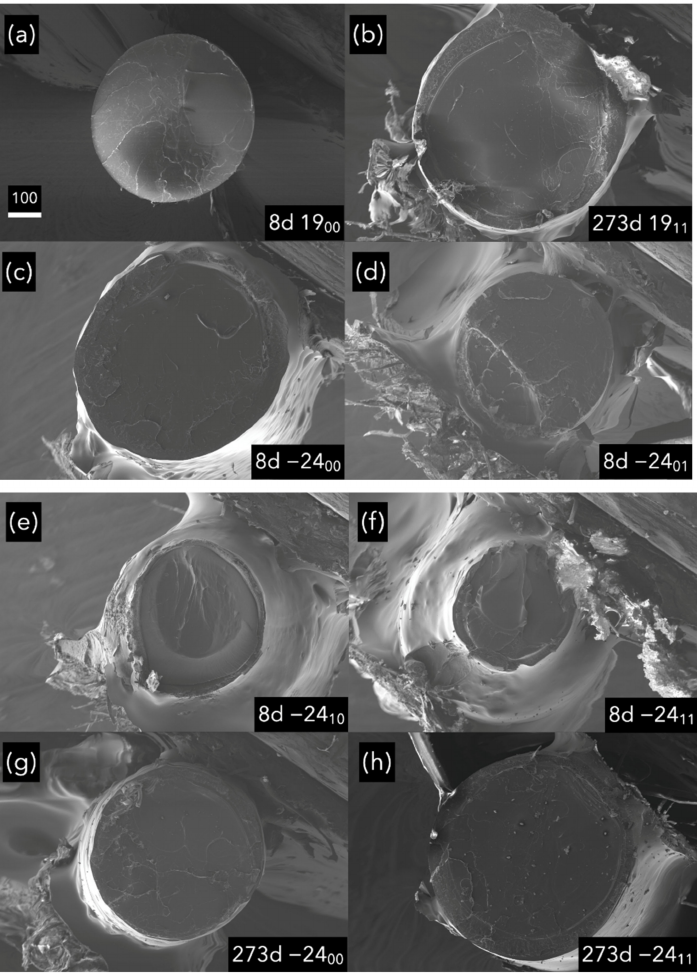
Figure 17. Samples without necking. Scale in microns. ( a , b ), samples aged at room temperature; ( c – h ), samples aged at − 24 ◦